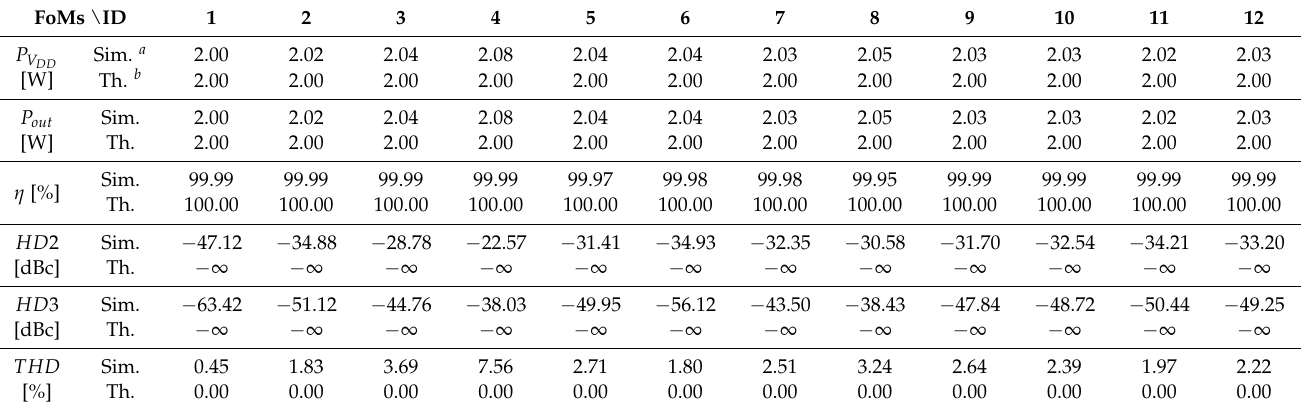
Table 8. Power and distortion Figures of Merit (FoM) of the designed